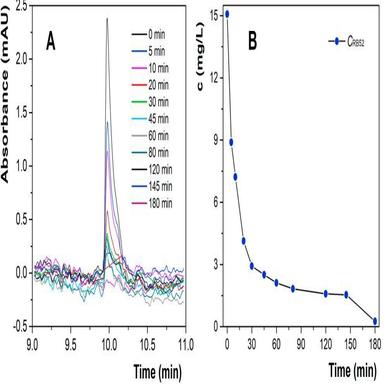
A) Chromatogram of RB52 samples in KCl (0.05 M), pH 5.6 using Eu2O3/SPCE, monitored on HPLC-DAD, 615 nm; B) The decrease of RB52 concentration after 3 h of treatment, quantified by HPLC-DAD, 280 nm.